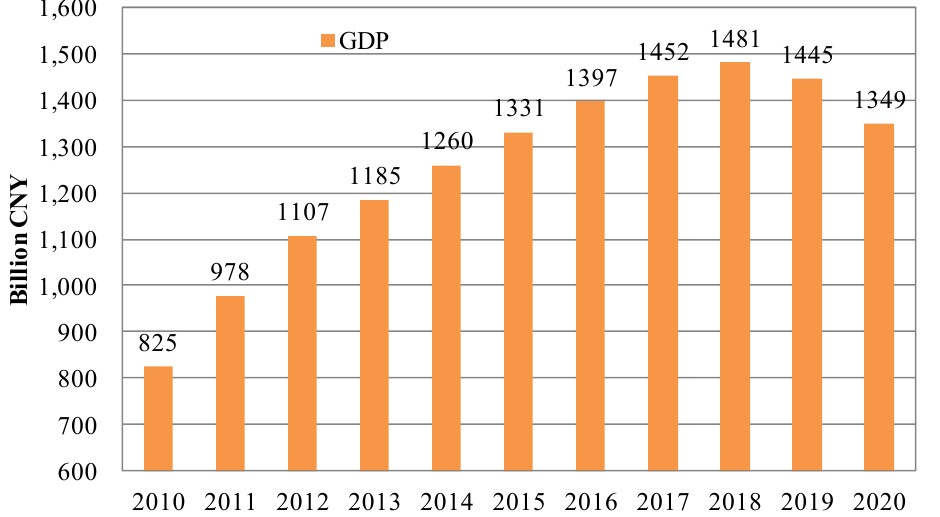
Figure 4. Estimate of GDP from 2010 to 2020.